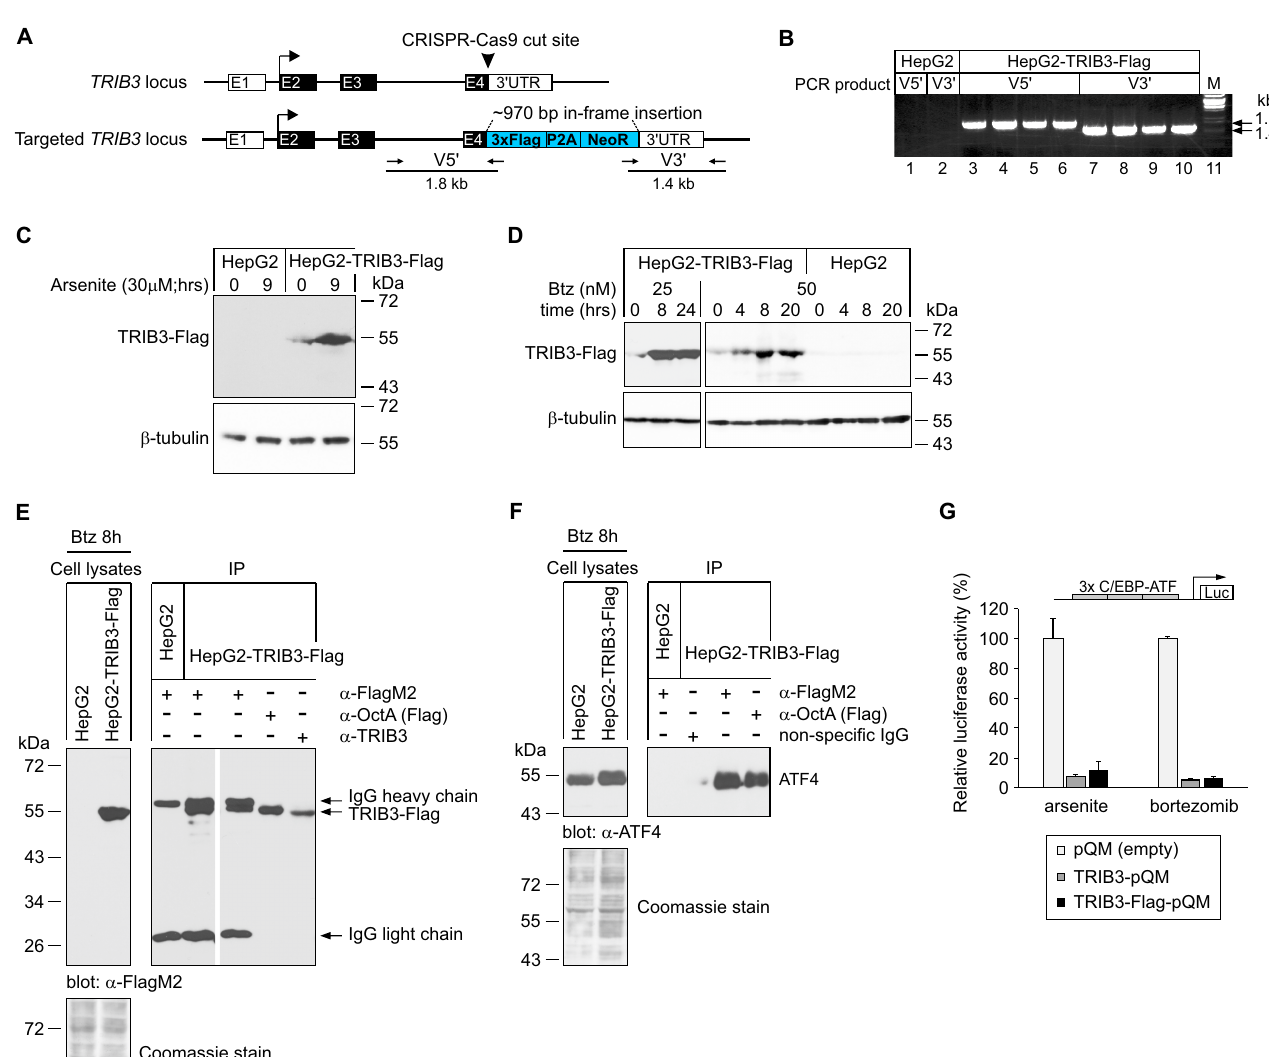
Figure 5. Generation and characterization of HepG2 cells expressing endogenous TRIB3 fused with Flag tag (HepG2-TRIB3- Flag cells). ( A ) Schematic representation of CRISPR-directed recombination in the TRIB3 locus, resulting in TRIB3 protein fusion with Flag tag. Boxes E1–E4 denote TRIB3 exons (the coding region is in the black background) and the translational initiation codon is marked with an arrow in exon 2. At the bottom, small arrows denote PCR amplicons used to validate the integration of the Flag donor cassette from 5 (cid:48) (V5 (cid:48) ) and 3 (cid:48) direction (V3 (cid:48) ). ( B ) PCR validation of Flag donor cassette insertion into the TRIB3 locus. Lanes 3 and 7 are from cell pools, while lanes 4–6 and 8–10 represent individual clones. ( C , D ) Stress-induced upregulation of endogenous TRIB3 fused with Flag tag. HepG2-TRIB3-Flag cells or unedited HepG2 cells were exposed to arsenite ( C ) or bortezomib (Btz; D ). Anti-Flag antibody was used for immunoblotting, along with anti- β -tubulin as a loading control. The blots shown are representative of 4 ( C ) or 2 ( D ) experiments. ( E ) Immunoprecipitation (IP)-based confirmation of TRIB3-Flag protein identity. Monoclonal M2 anti-Flag, polyclonal OctA-Probe anti-Flag and anti-TRIB3 antibodies were used for immunoprecipitation, and monoclonal M2 anti-Flag antibody was used for detection. ( F ) ATF4 coimmunoprecipitates with TRIB3-Flag. Proteins were immunoprecipitated from cell lysates using monoclonal M2 anti-Flag, polyclonal OctA-Probe anti-Flag or non-targeting IgG. Anti-ATF4 antibody was used for detection. ( G ) The C-terminally fused 3xFlag tag does not affect the ability of TRIB3 to inhibit the transcriptional activity of ATF4. HepG2 cells were cotransfected with human TRIB3 promoter reporter construct containing three C/EBP–ATF sites and expression plasmid for either TRIB3 (TRIB3-pQM), TRIB3 fused with Flag tag (TRIB3-Flag-pQM) or empty vector (pQM). The cells were exposed to 30 µ M arsenite or 50 nM Btz for 9 h. The reporter activities (mean ± SD) from two independent experiments are shown normalized to the reporter activity in control (pQM-transfected)